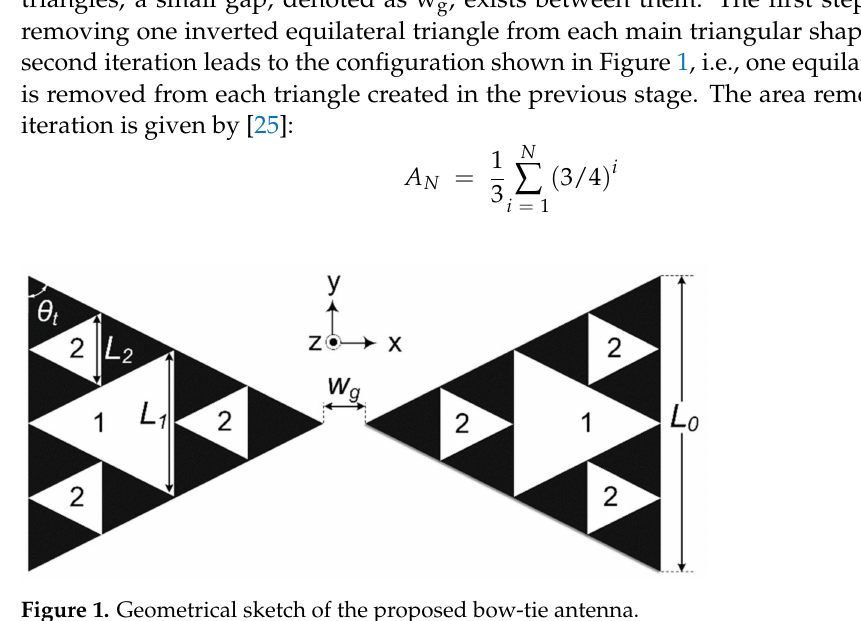
Figure 1. Geometrical sketch of the proposed bow-tie